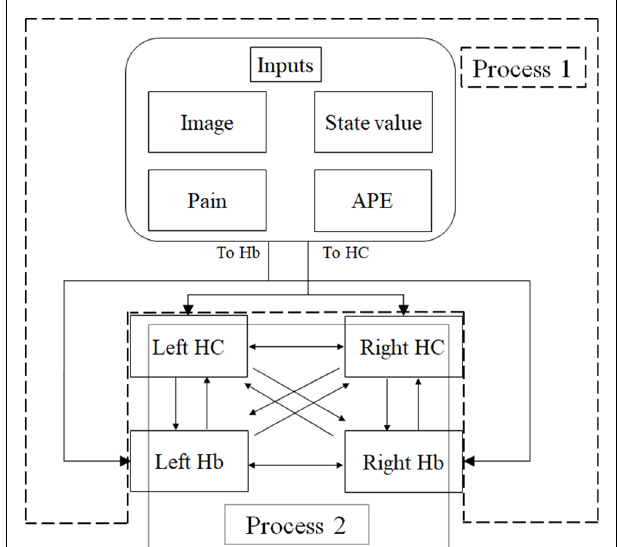
FIGURE 3 | An overview of dynamic causal modeling (DCM). We tested multiple combinations of inputs, input regions, and connections by using this model, and chose the best combination that explains the BOLD signals using a Bayesian model selection procedure that computed the posterior probability (the probability of the model given the data) over the competing models that were used. First, we estimated inputs and input regions under the fully-connected brain regions (Process 1). Second, we estimated the effective connectivity between the brain regions under the estimated inputs and input regions (Process 2). APE, aversive prediction error; HC, hippocampus; Hb,